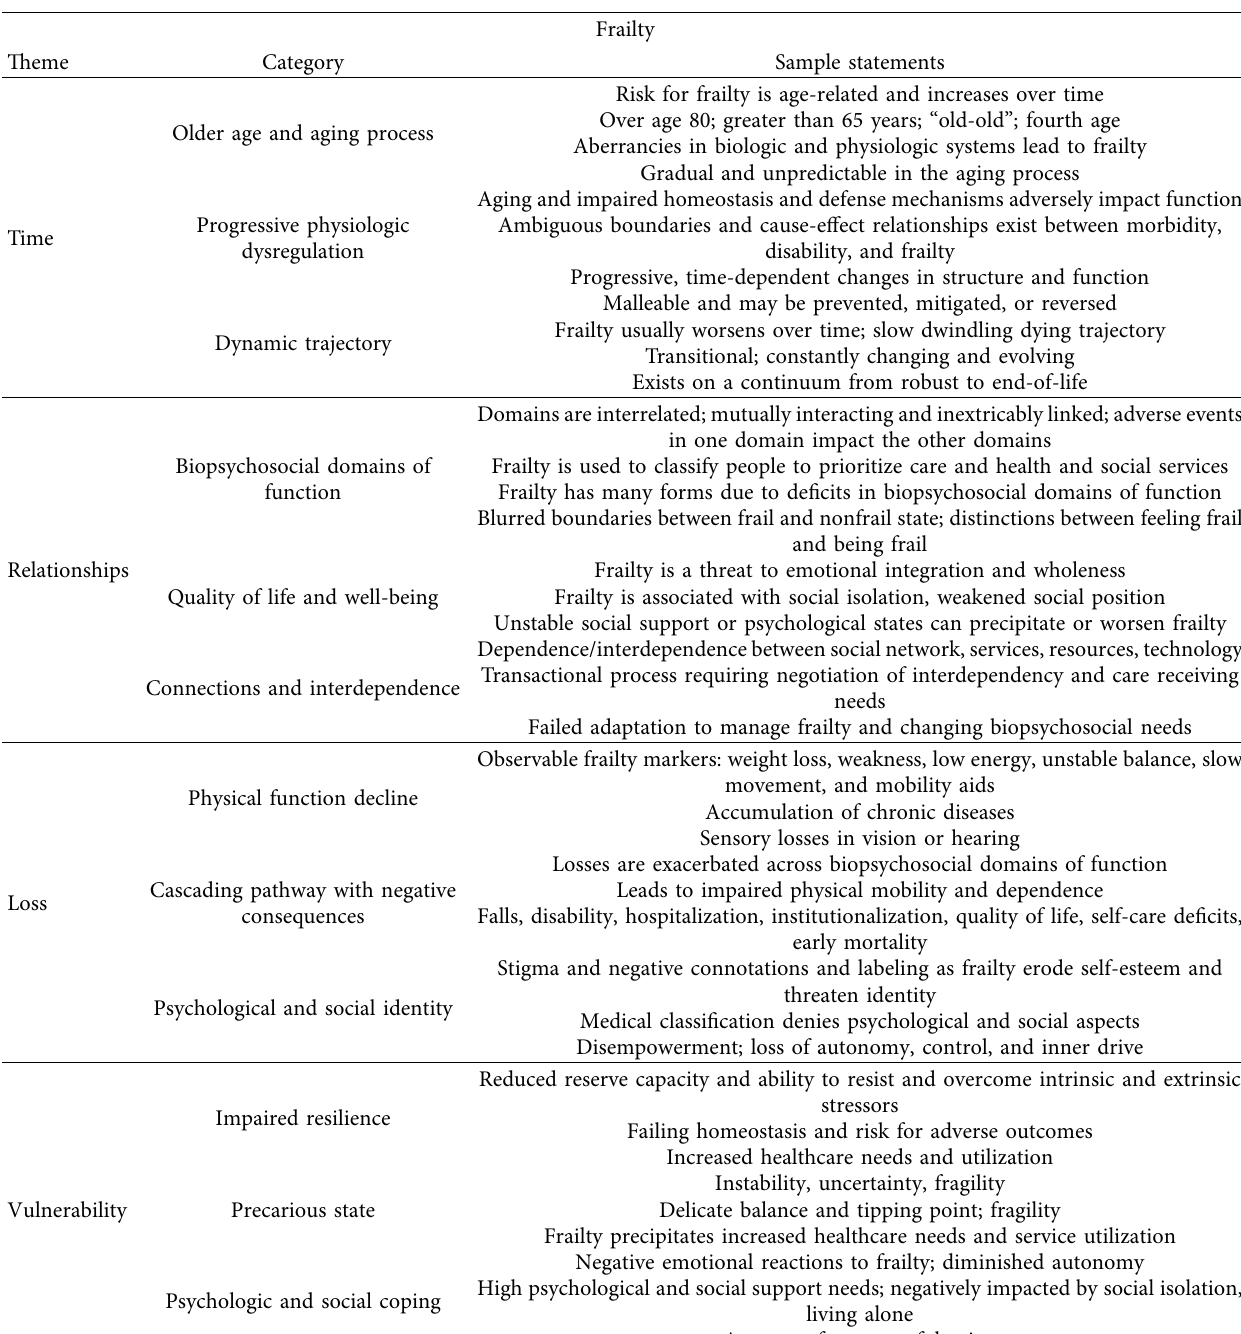
Table 4: Frailty concept map themes, categories, and